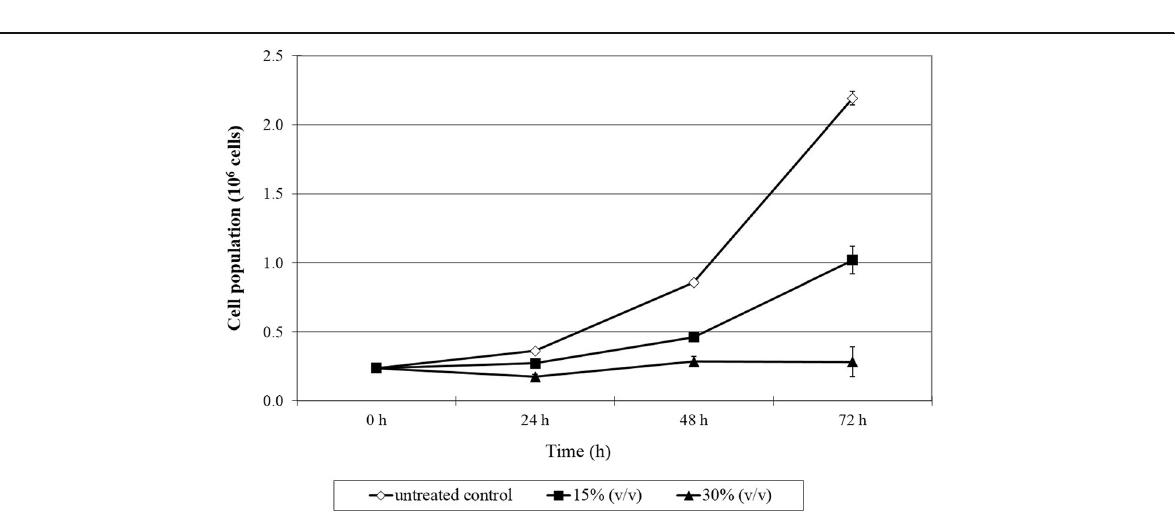
Fig. 3 Antiproliferative effect of PM produced by Lactobacillus plantarum I-UL4 on MCF-7 cells determined via trypan blue staining and cell count. Cell population equals to the viable cell concentration of a single well multiplied with 100 μ l of complete growth media used to suspend the cell pellet. Values within the same row and experiment having an asterisk indicate significant difference ( P < 0.05) from the untreated control groups. Error bars represent the standard error of the mean